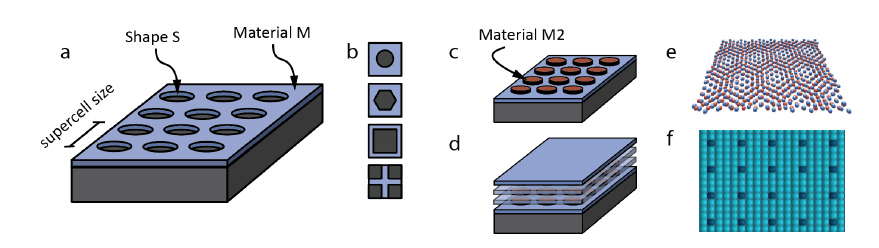
Figure 2: Fabrication methods. a , Modern nanofabrication tools allow one to make nano- patterned shapes with supercell periodicities of (cid:174) 5 to 50 lattice constants. b , Different shapes have different effects on the resulting electron-phonon coupling parameter λ . c , Different layers of (insulating) materials on top of the thin films will influence the phonon and elec- tron dispersions individually and can increase the phonon energies. d , Stacking allows for 3D materials. e,f , Smaller patterning are possible using Moiré engineering or single atom